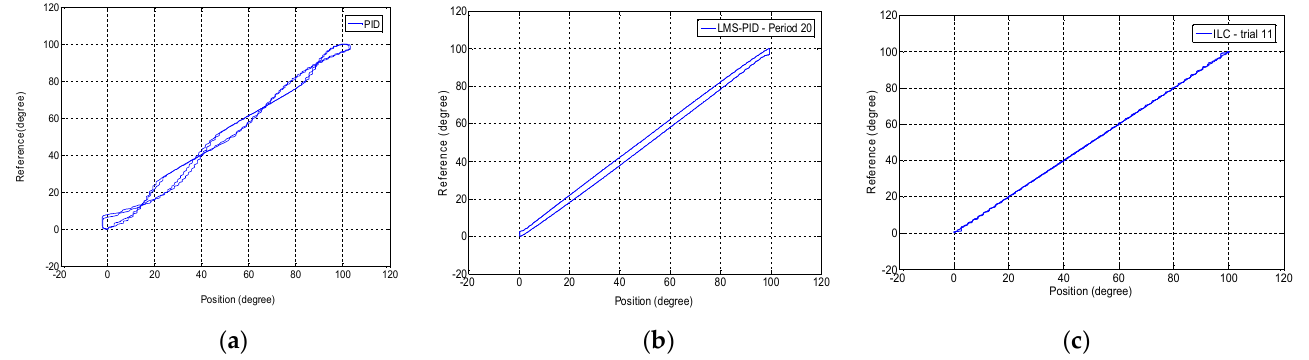
19 of 29 Figure 14. Convergence curves of RMSE with different learning rates under tracking experiment. Then, the relationship between the desired trajectory (vertical axis) and the actual trajectory results from each controller (horizontal axis) is plotted. When comparing the